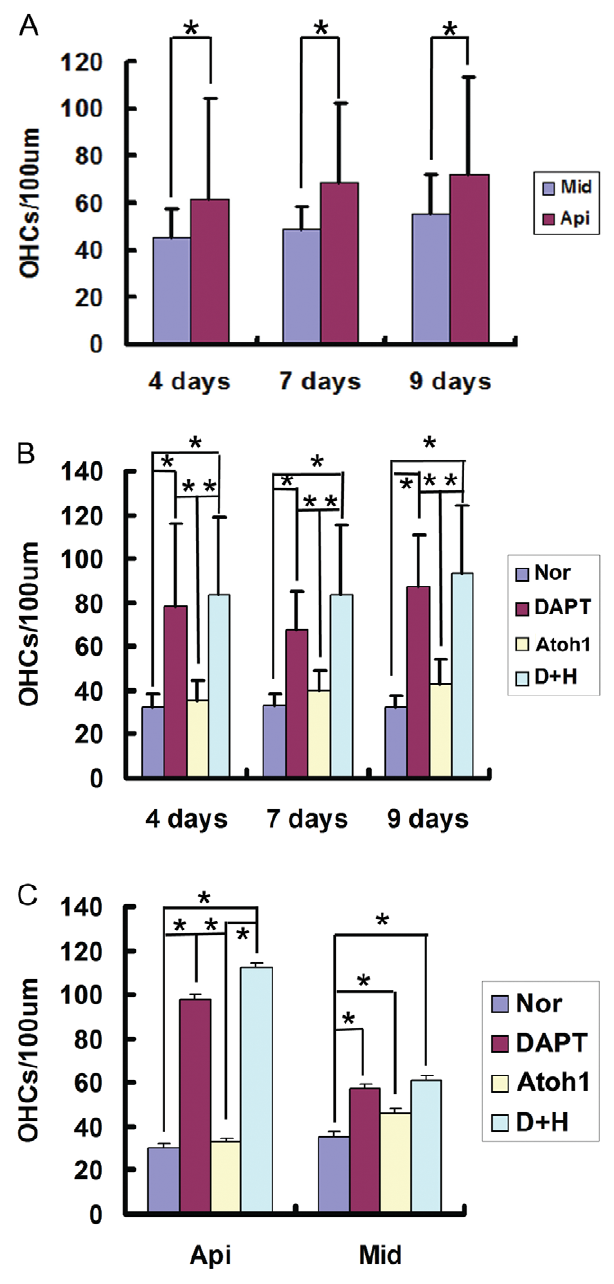
Figure 4. Statistical analysis of OHCs number after Atoh1 gene over expression and DAPT treatment. A. the number of OHCs